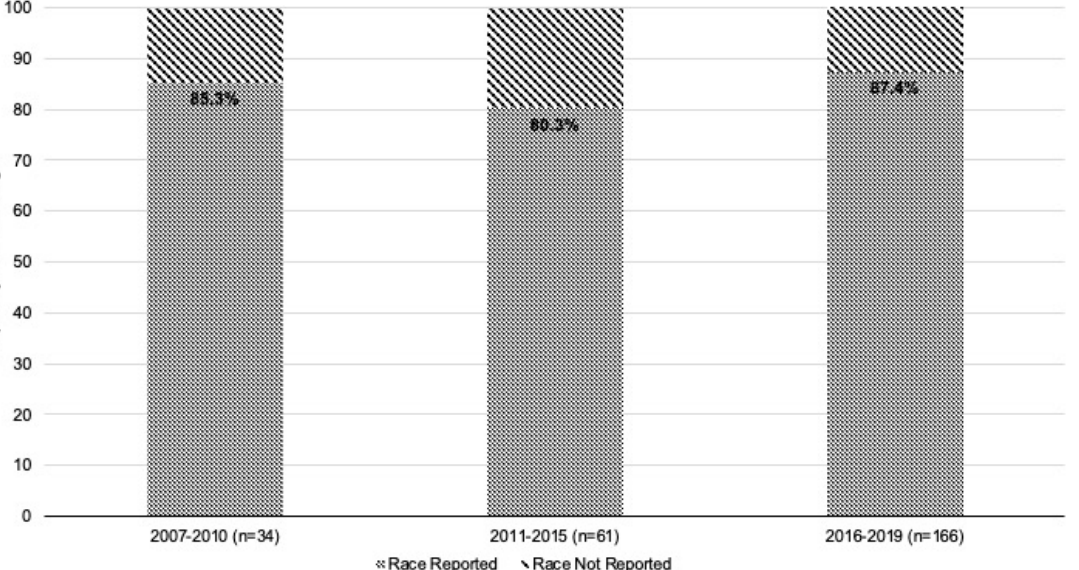
Figure 2. Trends in race reporting over time in clinical trials leading to cancer drug approval between 2007 and 2019.